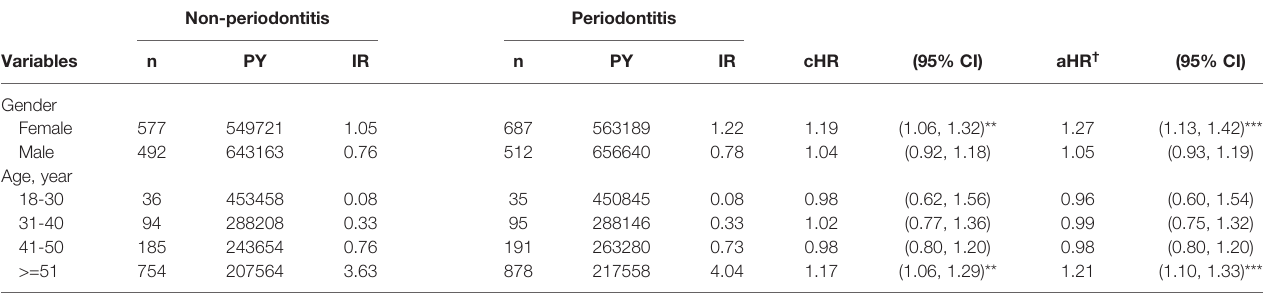
TABLE 4 | Subgroup analyses on risks of severe osteoarthritis that led to total knee or total hip replacement following periodontitis, based on sex and age strati fi cation. Non-periodontitis